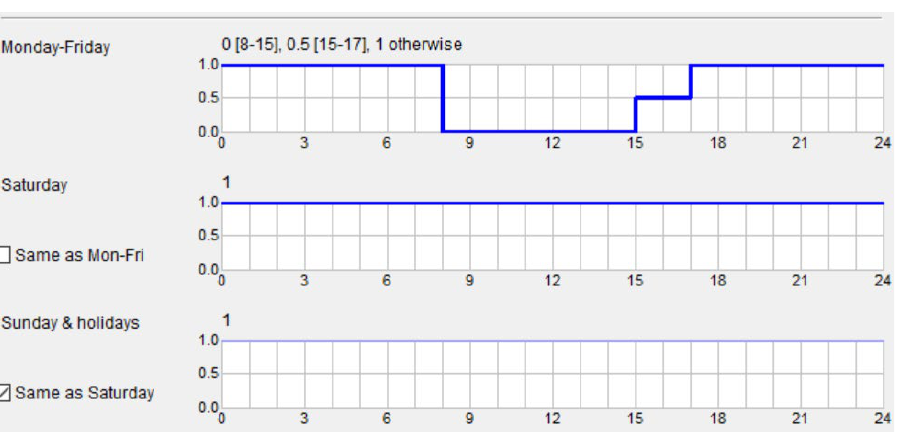
Fig. 6. Optimized building simulation model – mechanical ventilation system equipped with heat recovery unit: mechanical ventilation operation